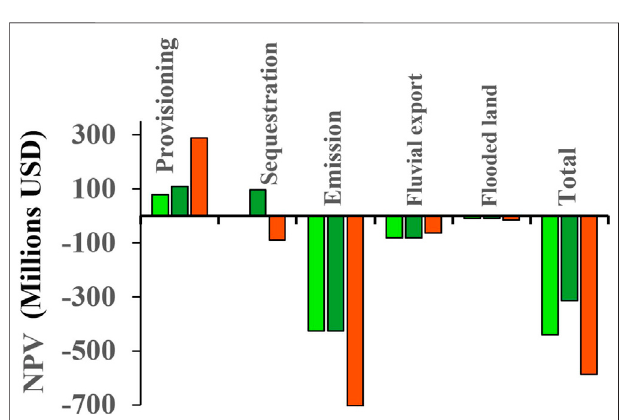
FIGURE 5 | Total ecosystem service value